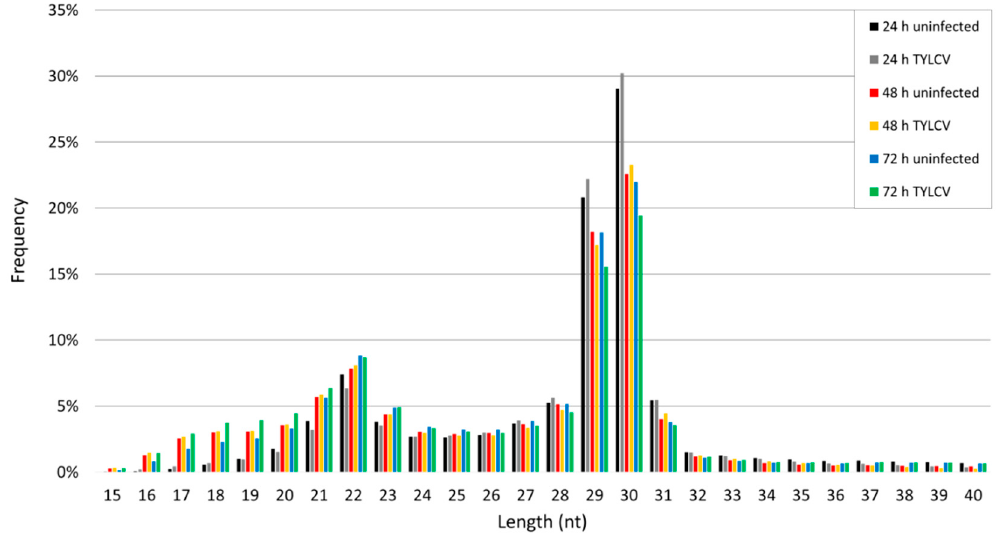
Figure 1. Frequency of read lengths. Distribution of small RNAs identified in whiteflies ( B. tabaci ) that fed on tomato yellow leaf curl virus (TYLCV)-infected tomato or uninfected tomato for 24, 48, and 72 h. Table 1. Number of conserved and B. tabaci -specific microRNAs identified in this study. No. miRNAs Length Conserved